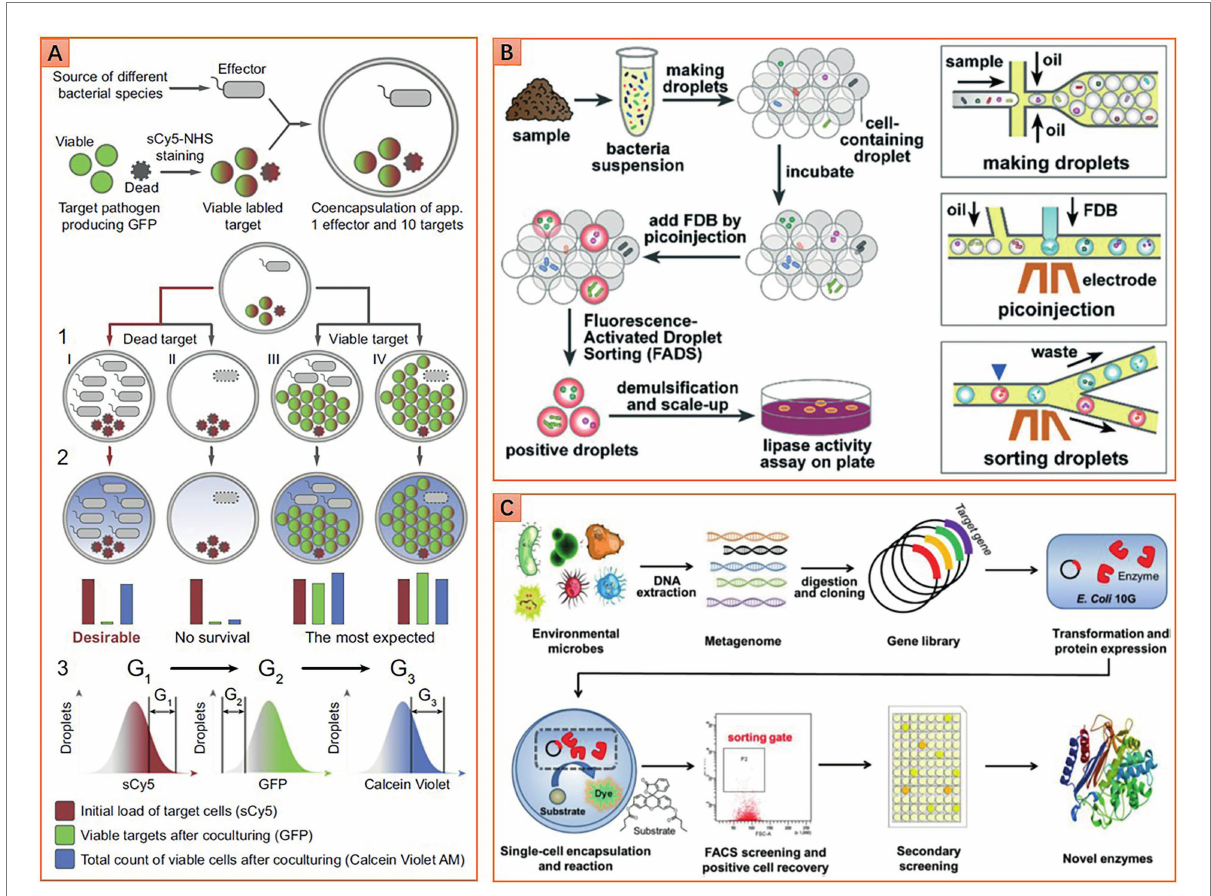
FIGURE 5 Diverse microfluidic approaches for phenotype screening and sorting. (A) Screening microbes with antimicrobial ability, double emulsion droplets are detected and sorted by flow cytometer (Reprinted from Terekhov et al., 2017 with the permission of National Academy of Sciences); (B) Screening lipolytic microorganisms based on fluorescence-activated droplet sorting (FADS) method (Reprinted from Qiao et al., 2018 with the permission of Royal Society of Chemistry); and (C) Screening esterase genes from the metagenomic library based on a flow cytometric droplet sorting method (Reprinted from Ma et al., 2021 with the permission of John Wiley and